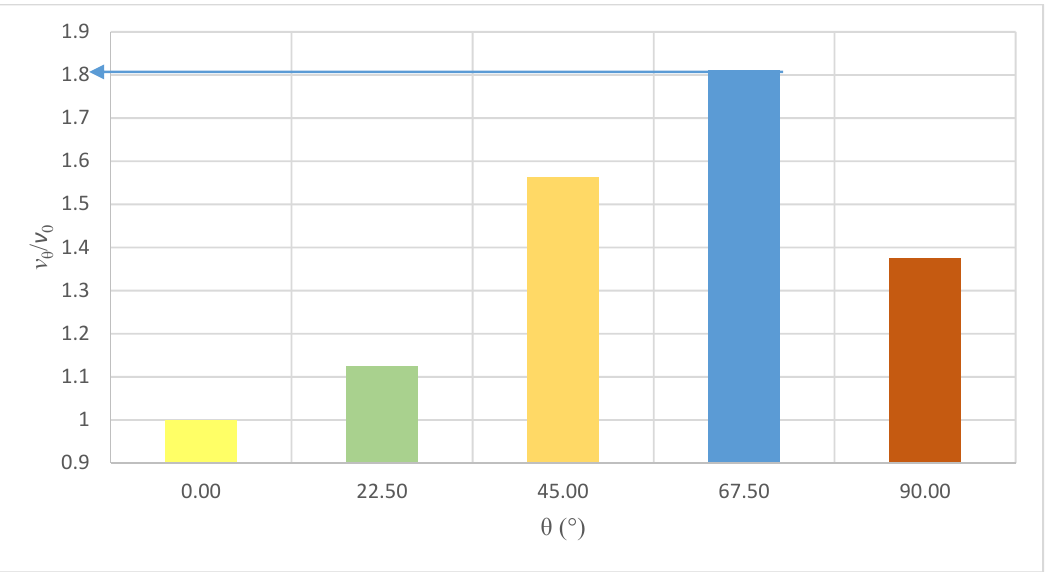
Figure 10. Changes in Poisson’s ratio ν θ / ν 0 in regard to the angle of the bed joints θ . The maximum value has been obtained with angle θ = 67.5°, with coefficient ν θ / ν 0 = 1.81. Figure 11 presents the representative Poisson’s ratio–stress curves of tested wall panels at different angles θ .